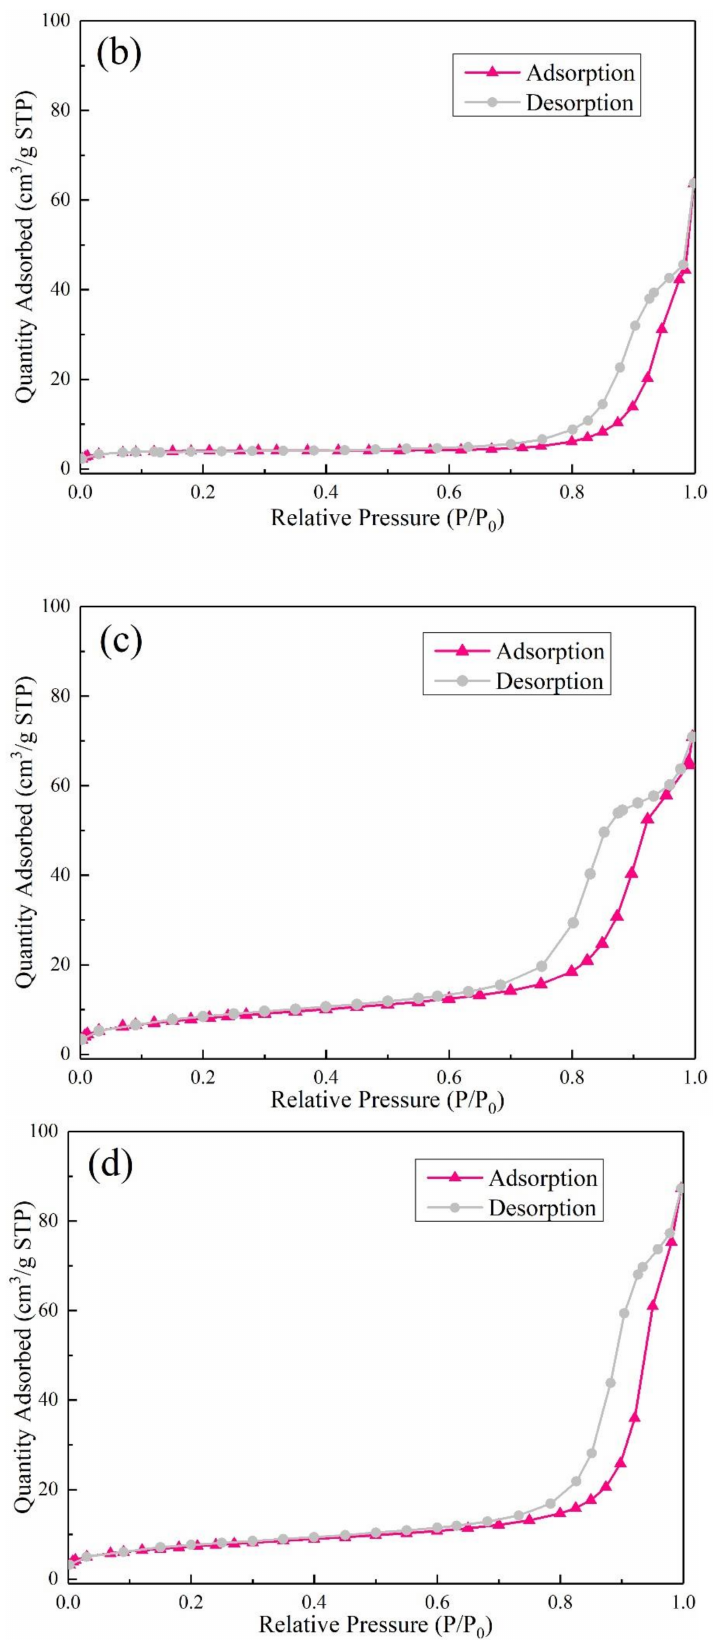
Figure 10. N 2 adsorption and desorption isotherms at 77 K of ( a ) FAA1.0, ( b ) AF0.5-2, ( c ) AF1-1, and ( d )